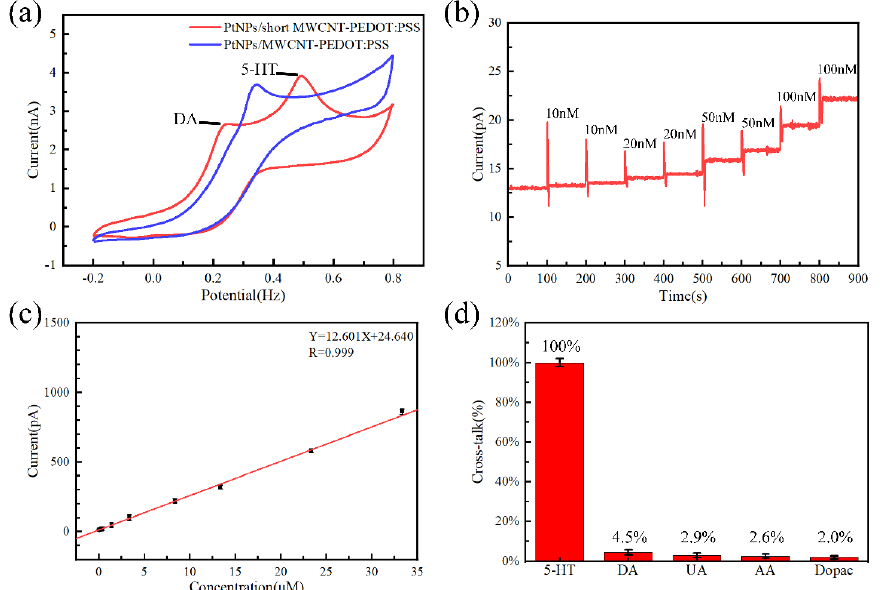
Figure 4. Electrochemical performance of the MEA. ( a ) The cyclic voltammetry of the MEA sites modified with PtNPs/MWCNT-PEDOT: PSS or PtNPs/short MWCNT-PEDOT: PSS in the solution contained DA (100 μ M) and 5-HT (100 μ M); ( b ) Minimum detection limit of the MEA tested at tiny concentrations of 5-HT solution; ( c ) The fitting curve between the 5-HT response current and the corresponding concentration; ( d ) Selective results of the 5-HT microelectrode arrays against common interferences. DA: dopamine; UA: uric acid; AA: ascorbic acid; DOPAC: 3,4-dihydroxyphenylacetic acid.